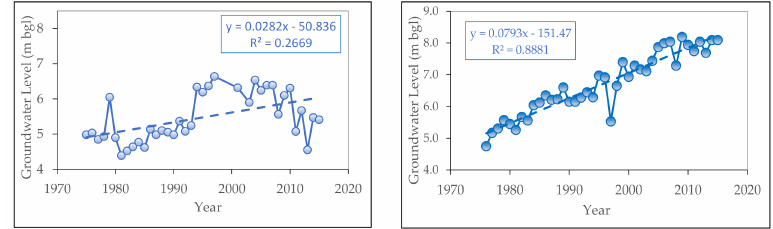
Figure 6. Trends in groundwater levels at Singair ( left ) and Parilnoadda ( right ).